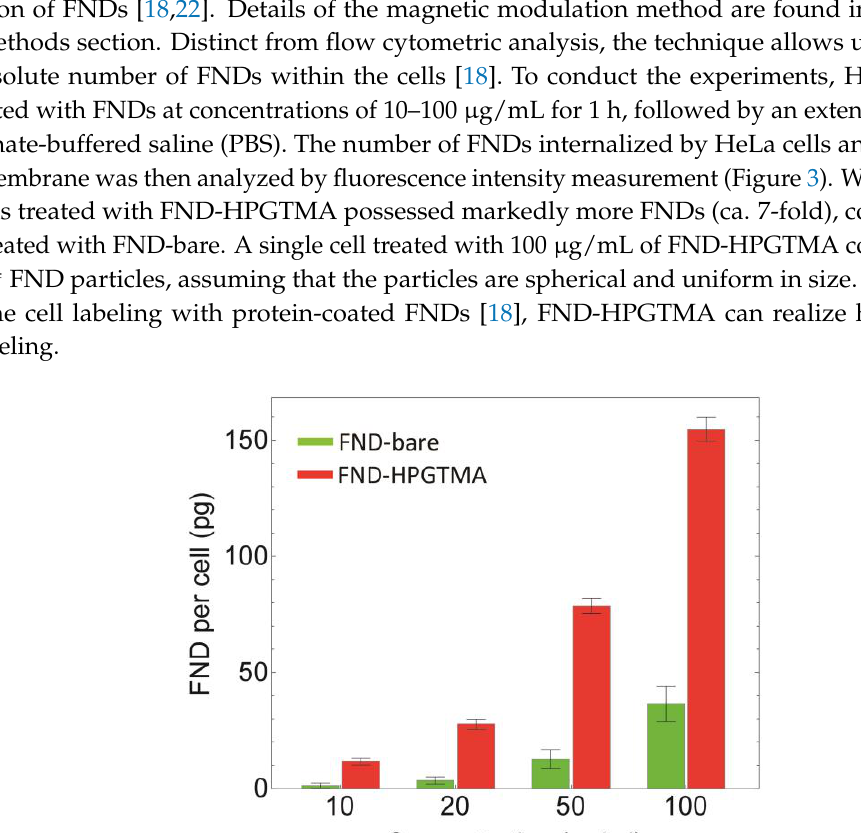
Figure 2. Cell viability testing of HeLa cells treated with FND-bare, FND-HPGTMA, and FND-PEI, and PEI for 24 h using CCK-8. Values are means ± standard deviations of three measurements. PEI: Polyethylenimine.